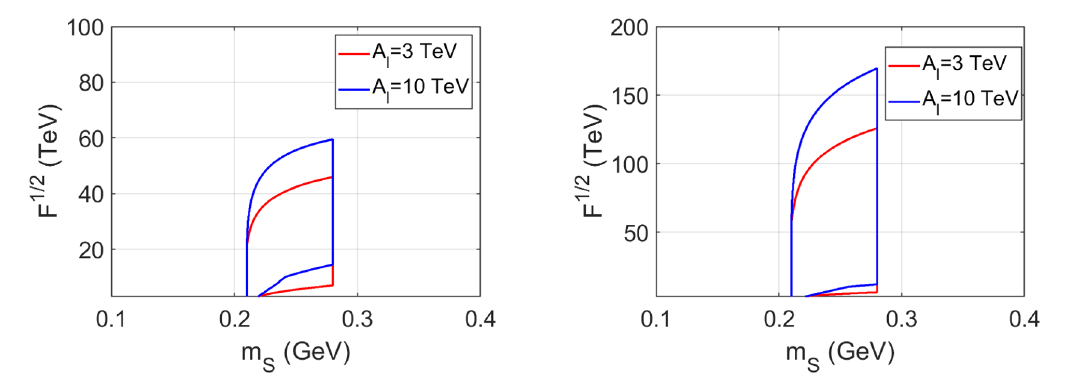
Figure 15 . The regions to be tested with the muon pair signature at FASER-I (left panel) and FASER-II (right panel). M 3 = 3 TeV. In the regions where